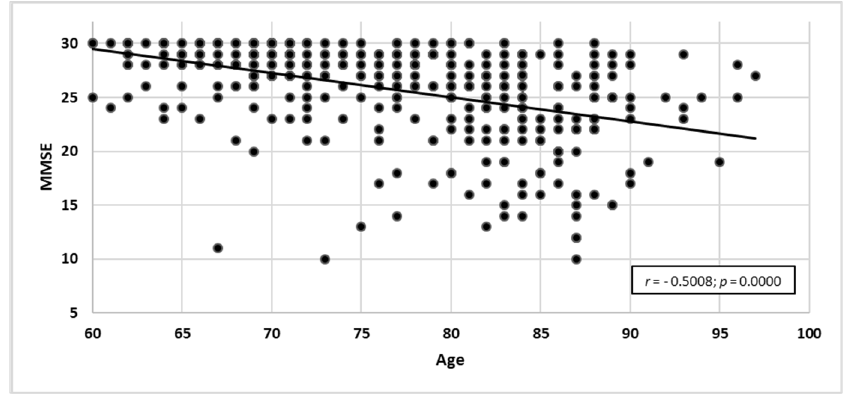
Figure 1. Age correlated with raw MMSE results.